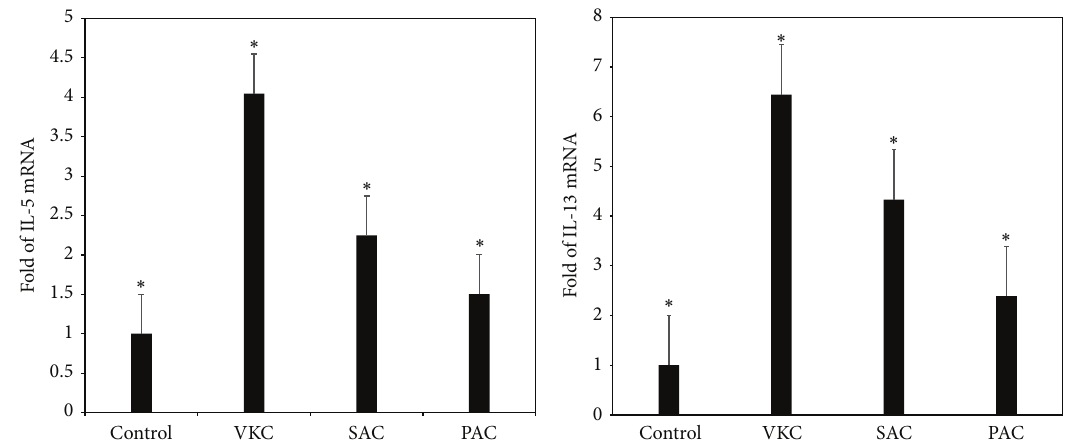
(a) Relative expression levels of TSLP mRNA in different types of allergic conjunctivitis